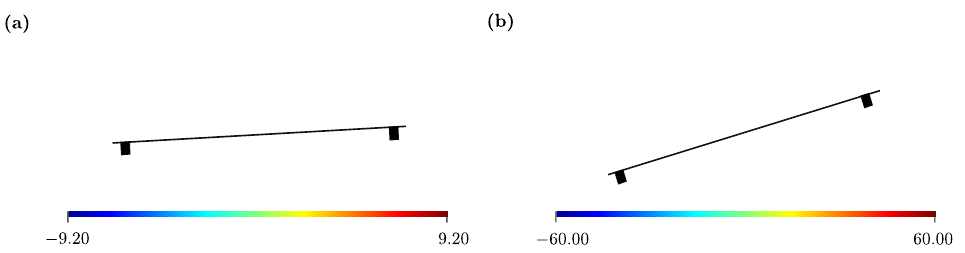
Figure 6. Pressure field [ µ Pa] for Micromirror 1 in a section generated by the e 2 − e 3 plane passing through the centre of the box at t = T p for α = 3.20 ◦ ( a ), and α = 16.60 ◦ ( b ).